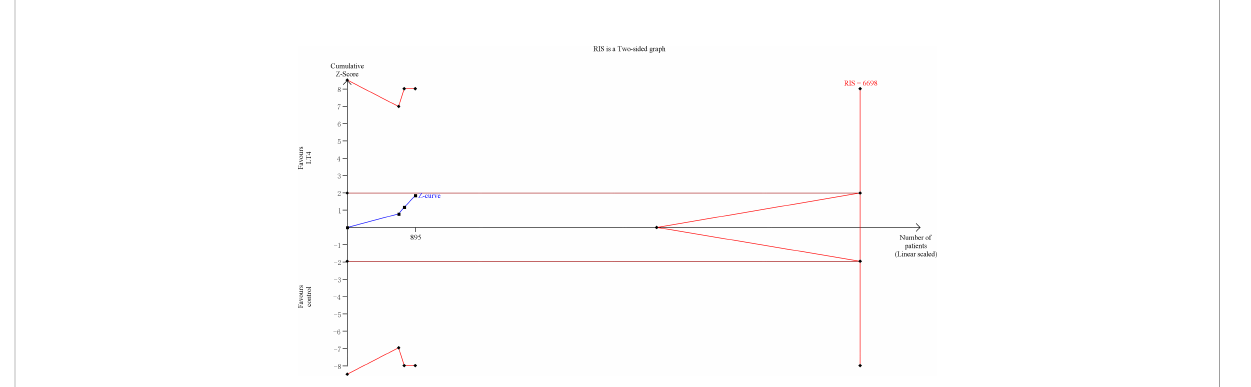
FIGURE 2 Trial sequential analysis of preterm delivery. The risk of typeIerror was set at 5% with a power of 80%. The variance was calculated from the data obtained from the included trials. The relative risk reduction (RRR) was set at